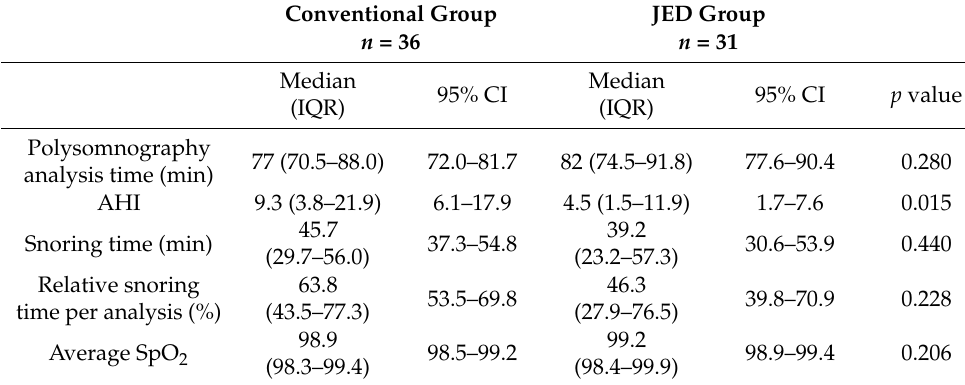
Table 4. Polysomnography